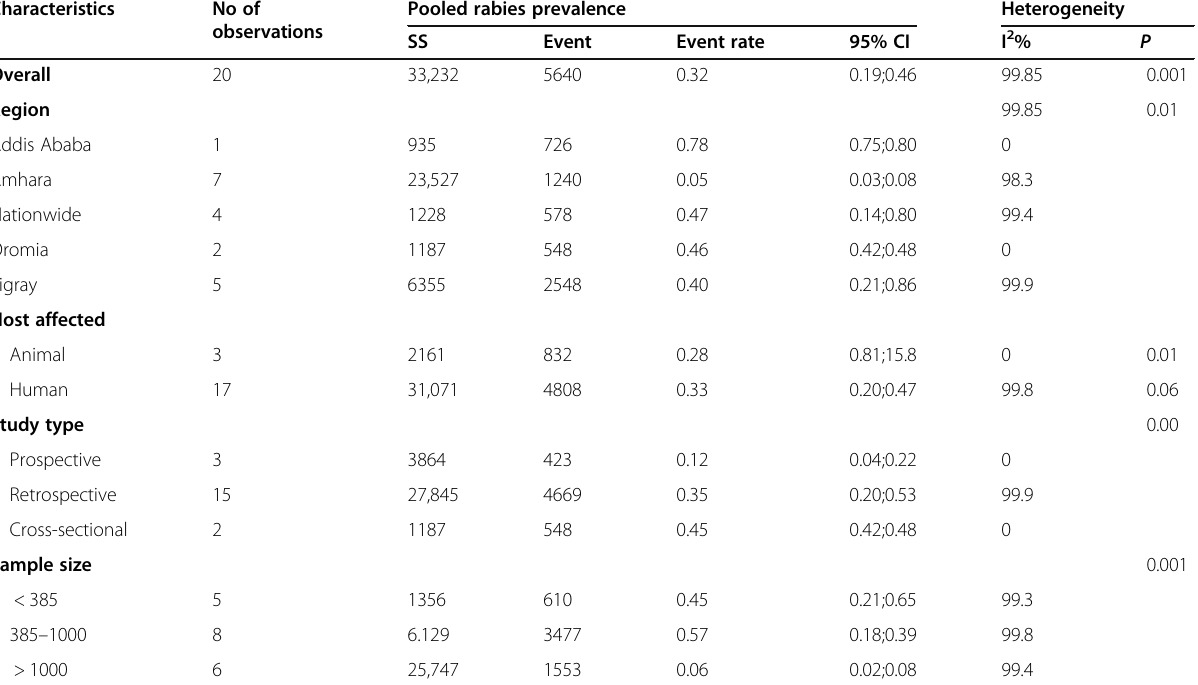
Table 2 Subgroup Meta-statistics